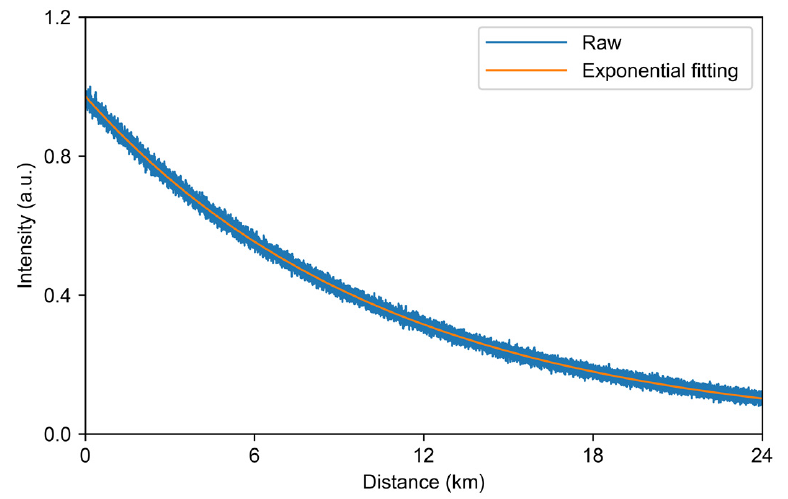
Figure 2. Distribution of AS signal.